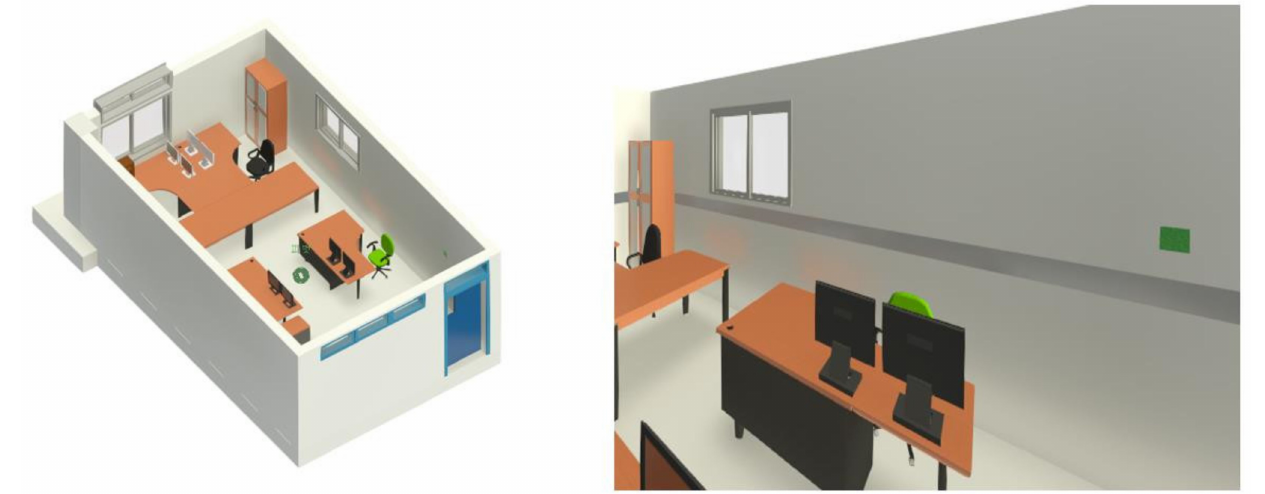
Figure 7. BIM drawings of a laboratory for system test.